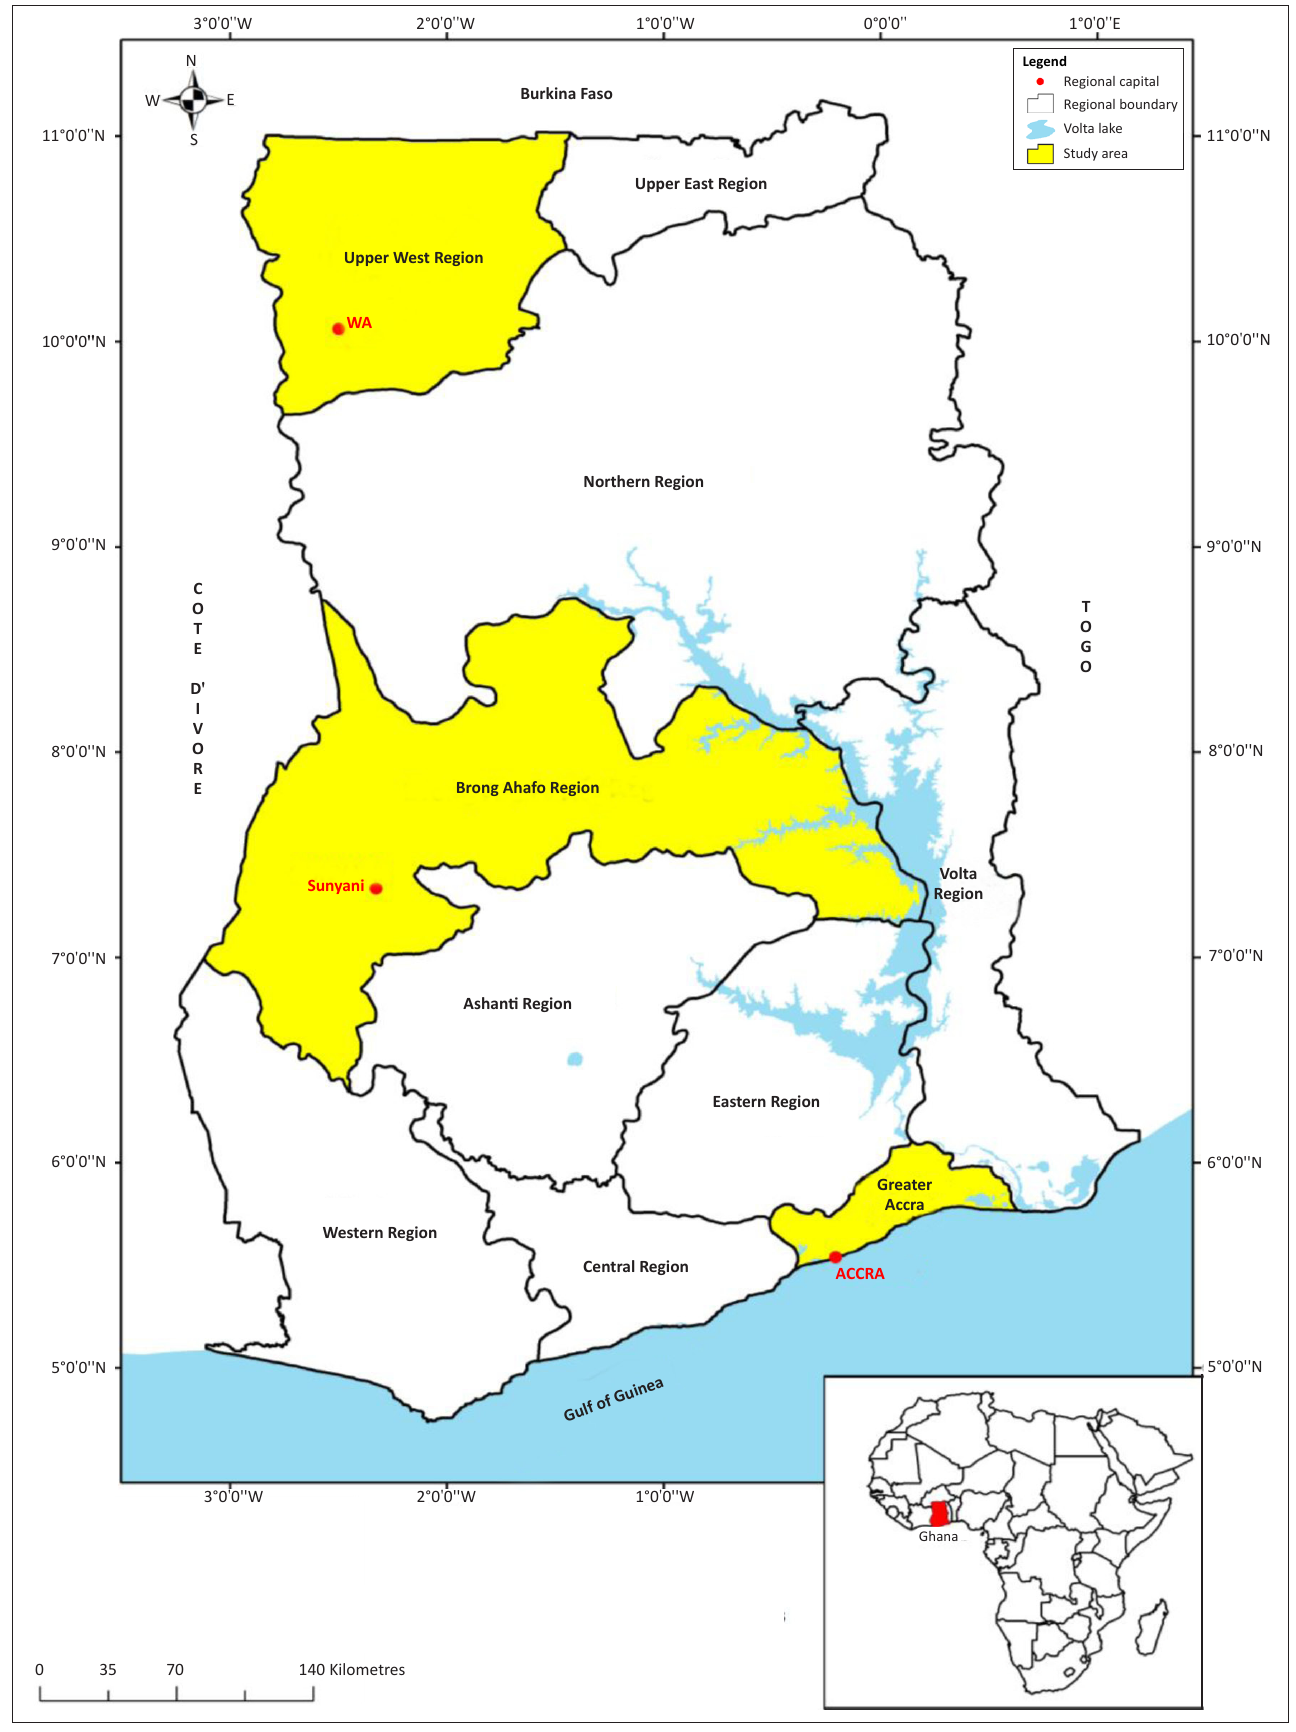
FIGURE 1: Map of Ghana, showing the research